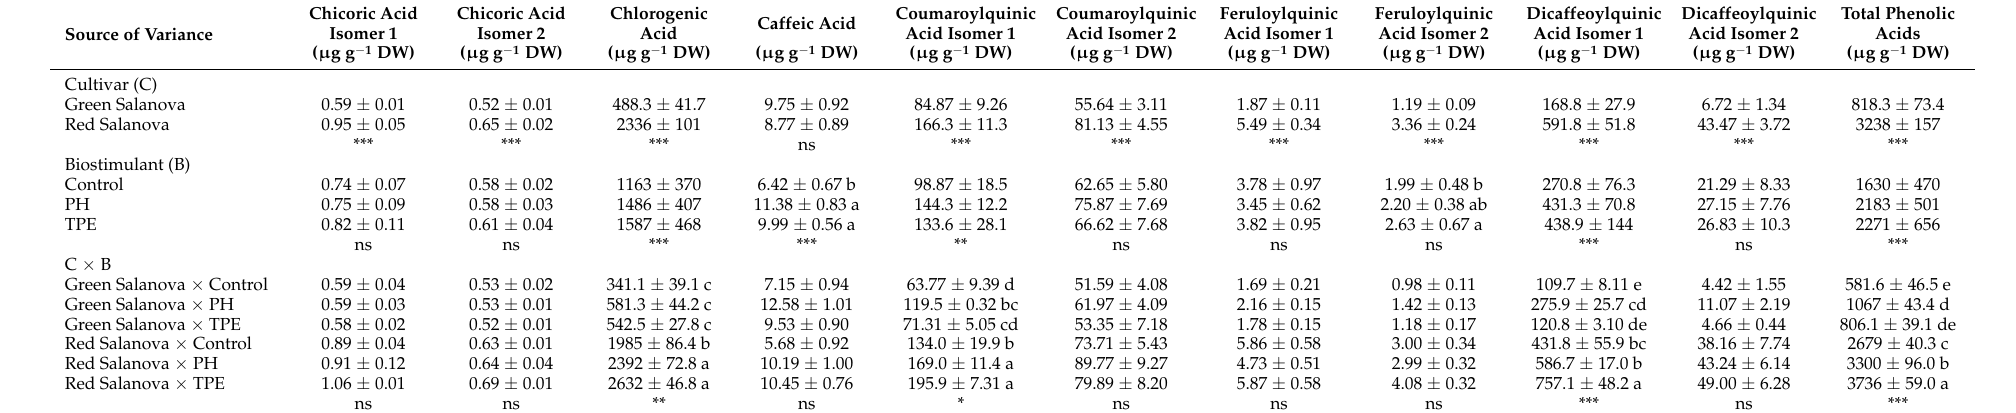
Table 5. Phenolic acid contents of red and green salanova lettuce and the influence of biostimulant treatments. Source of Variance